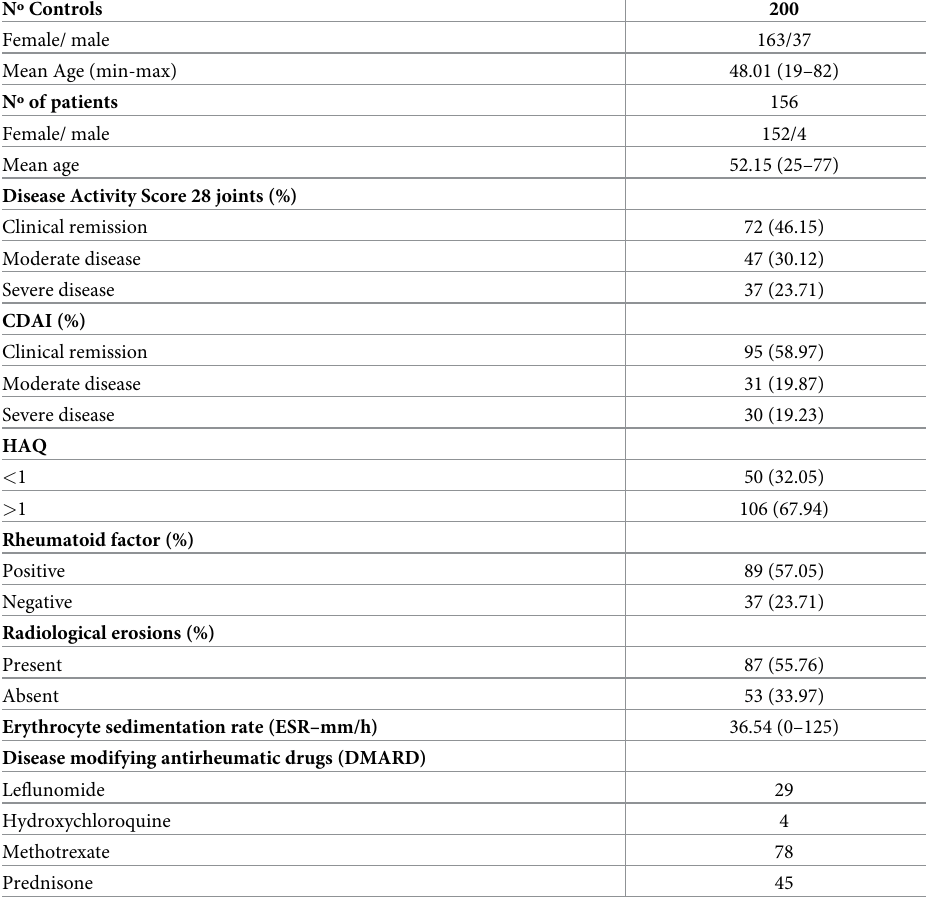
Table 1. Demographic and clinical parameters of RA patients and control